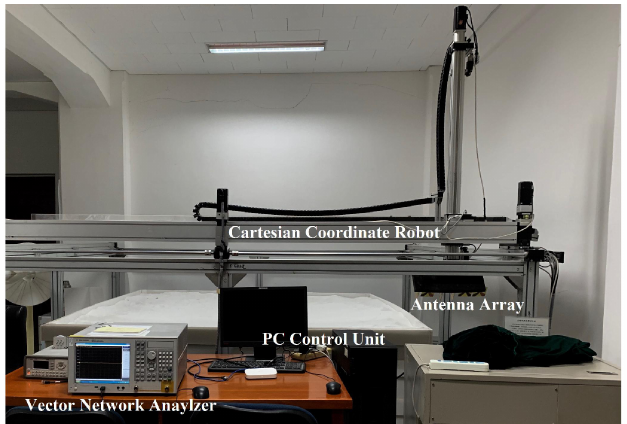
Figure 4. Four types of targets in the dry sand trough. (a) Metallic sphere. (b) Metallic cylinder. (c) Metallic dihedral. (d) Metallic multibranch.